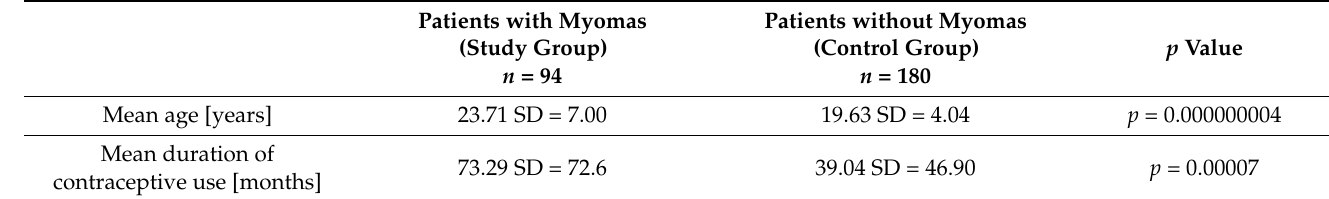
Table 2. Contraceptive use in the study and control